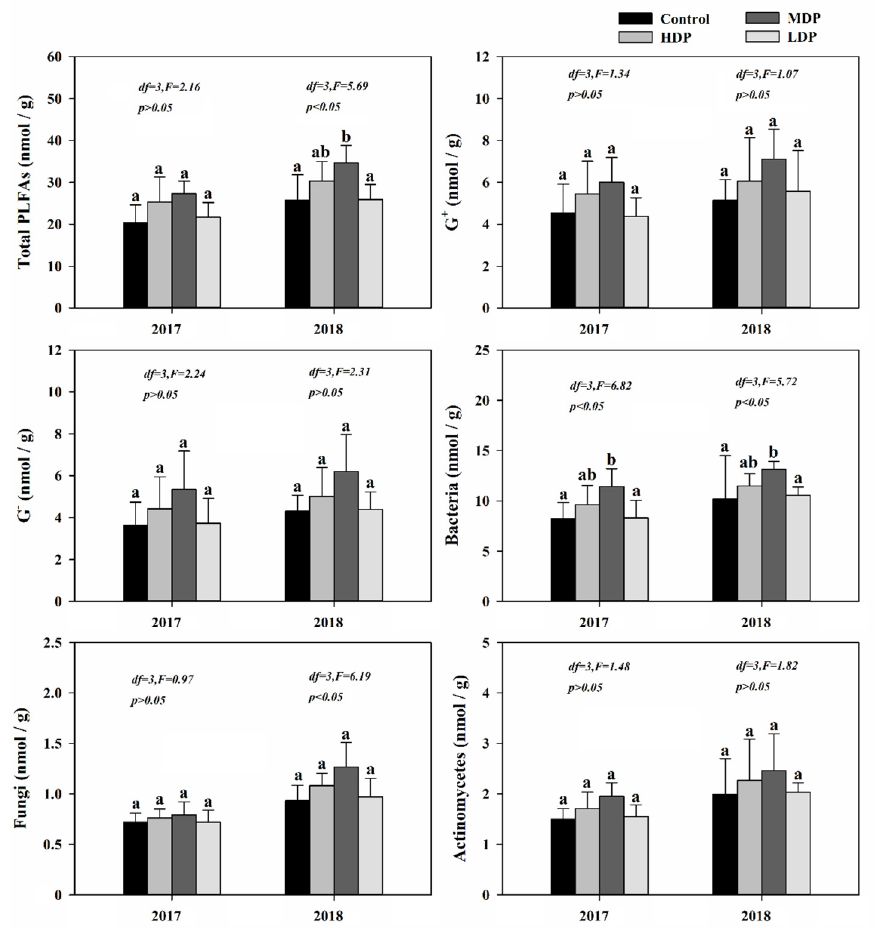
Figure 2. Soil microorganism PLFAs in L. principis-rupprechtii plantations with different density. Error bars indicate standard error ( n = 3). Different lowercase letters: p < 0.05, significant difference between